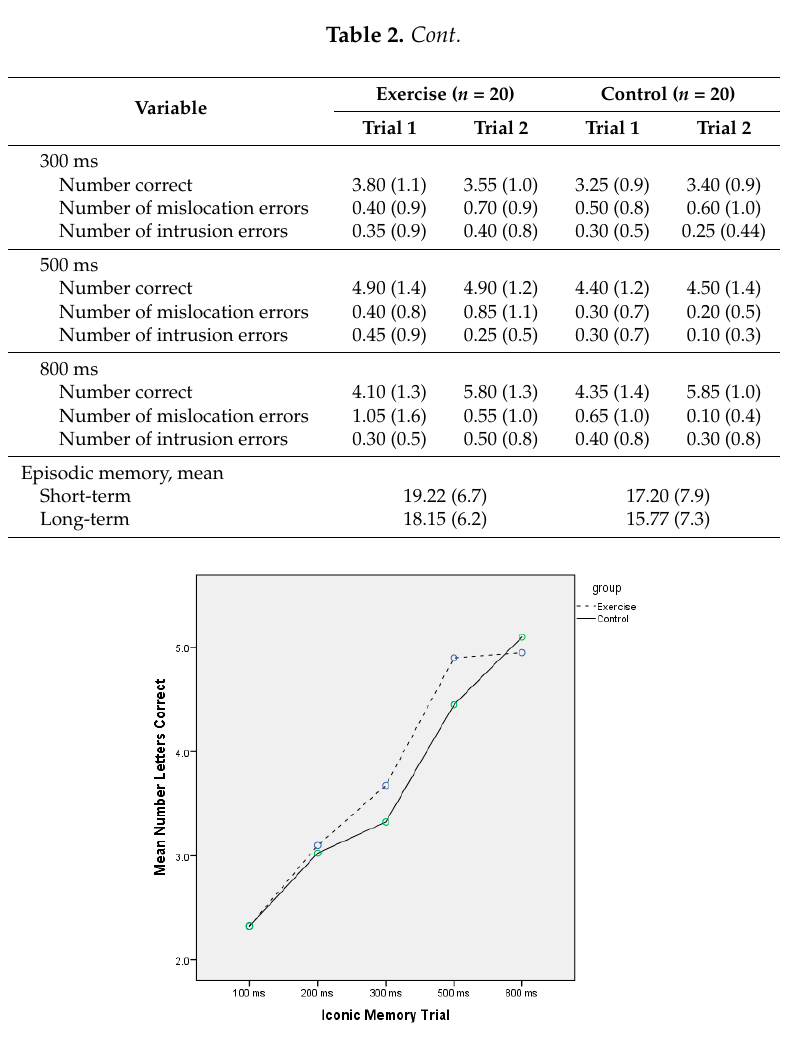
Figure 1. Iconic memory performance (absolute correct) across the experimental and control groups. Scores are the averages for each of the two trials for each temporal period. Results are presented from the shortest (100 ms) to longest (800 ms) iconic trials (in the experiment, trials were counterbalanced).